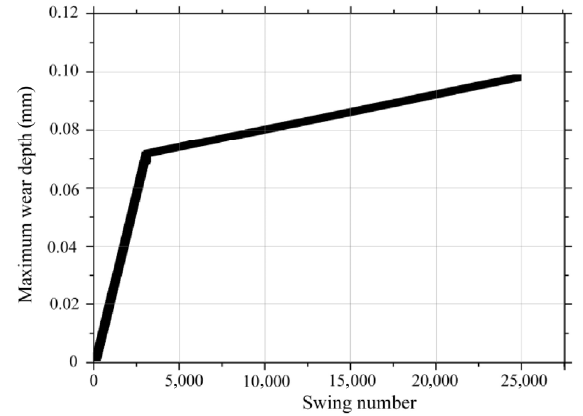
Fig. 8 The curve of the wear depth of fabric liners varies with swing numbers.